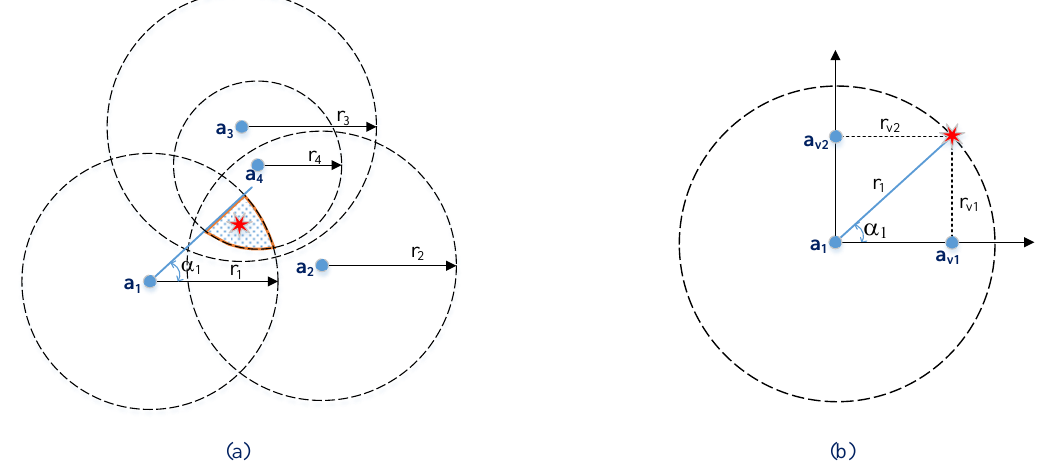
Figure 3. Unbalanced hybrid AOA/RSSI localization: ( a ) 1AOA/4RSSI and ( b ) Angular-to-ranging